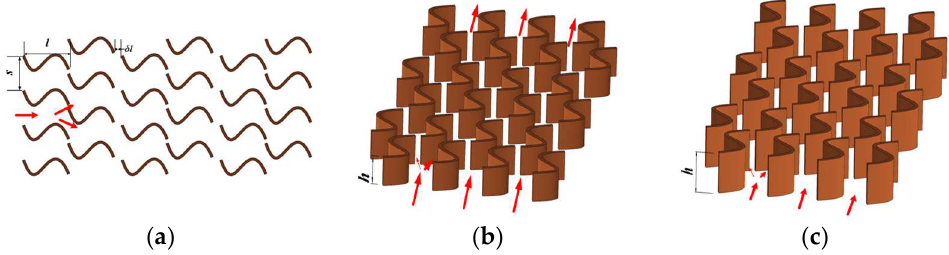
Figure 2. Structural dimensions of A1–A3 with OSF geometry. ( a ) A1 ( b ) A2 ( c ) A3.